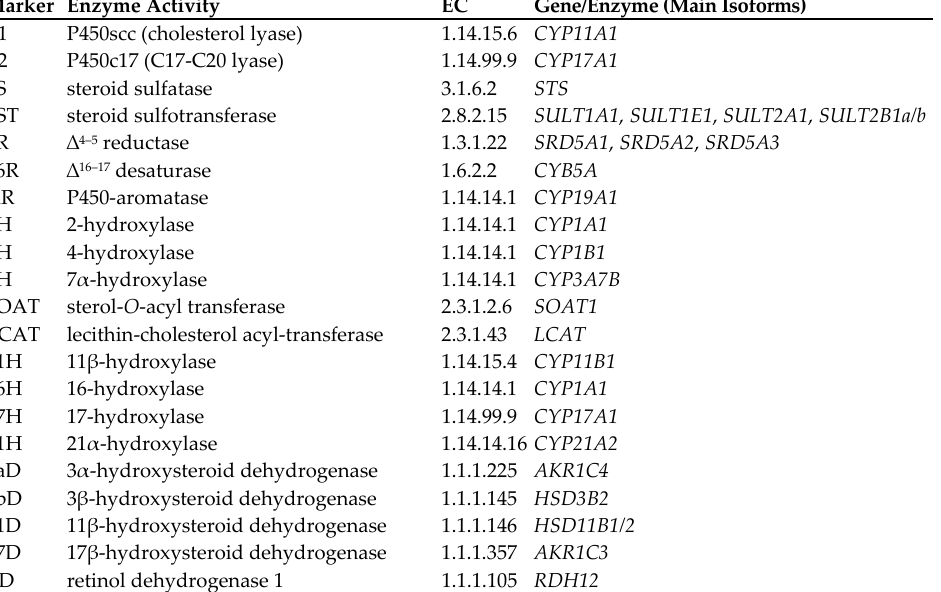
Figure 1. Main androgen sytntheis pathways. This figure represents the physiological molecular species secreted in/by adrenal glands (intermediate and cortical layers), testicles, ovaries and the brain, as well by a number of other organs or tissues with a critical participation in these processes (e.g., skin, liver, adipose tissue). Since the synthesis of androgens (especially in the adrenal glands) is closely related to the two parallel corticosteroid synthesis pathways (they share location and a few enzyme activities), the start of these paths has been indicated in green squares. This includes the estrogens, which metabolism is much more closely intertwined with that of the main androgens. The 16-[estriol] and 11-hydroxylative pathways, as well as the catechol-estrogen specific pathway, have been included only as annotations in green labels. Black arrows show the enzyme-driven changes between molecular species; two-headed arrows show reactions that are potentially bidirectional. The main androgen molecule borders are red, violet in those sharing androgen and estrogen capabilities and blue in the fully estrogenic molecules; the progestogen borders are marked in yellow, and the androgenic pheromone species are in grey. The remaining molecules (black borders) may show a limited (if any) androgen receptor binding ability. The enzymes intervening in the reactions depicted are listed below the figure. They are presented in borderless pale blue rectangles in contact with the corresponding black arrows; the letters are in brown for mitochondrial and black for microsomal (and other location) enzymes.